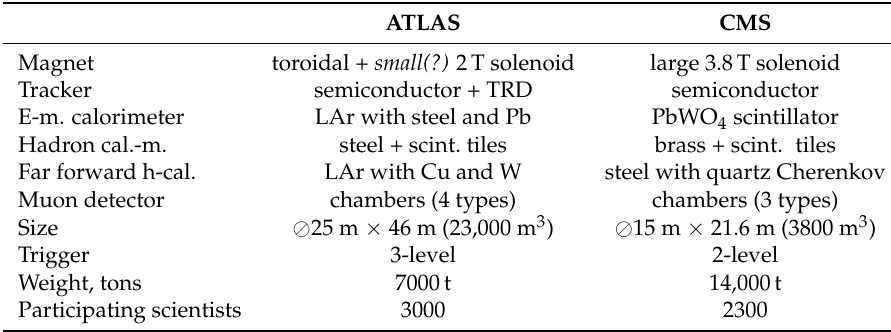
Table 2. Design and construction of the detectors of ATLAS and CMS. Very different measuring systems provide very similar data for the Higgs boson. TRD: transition radiation detector, E-m: